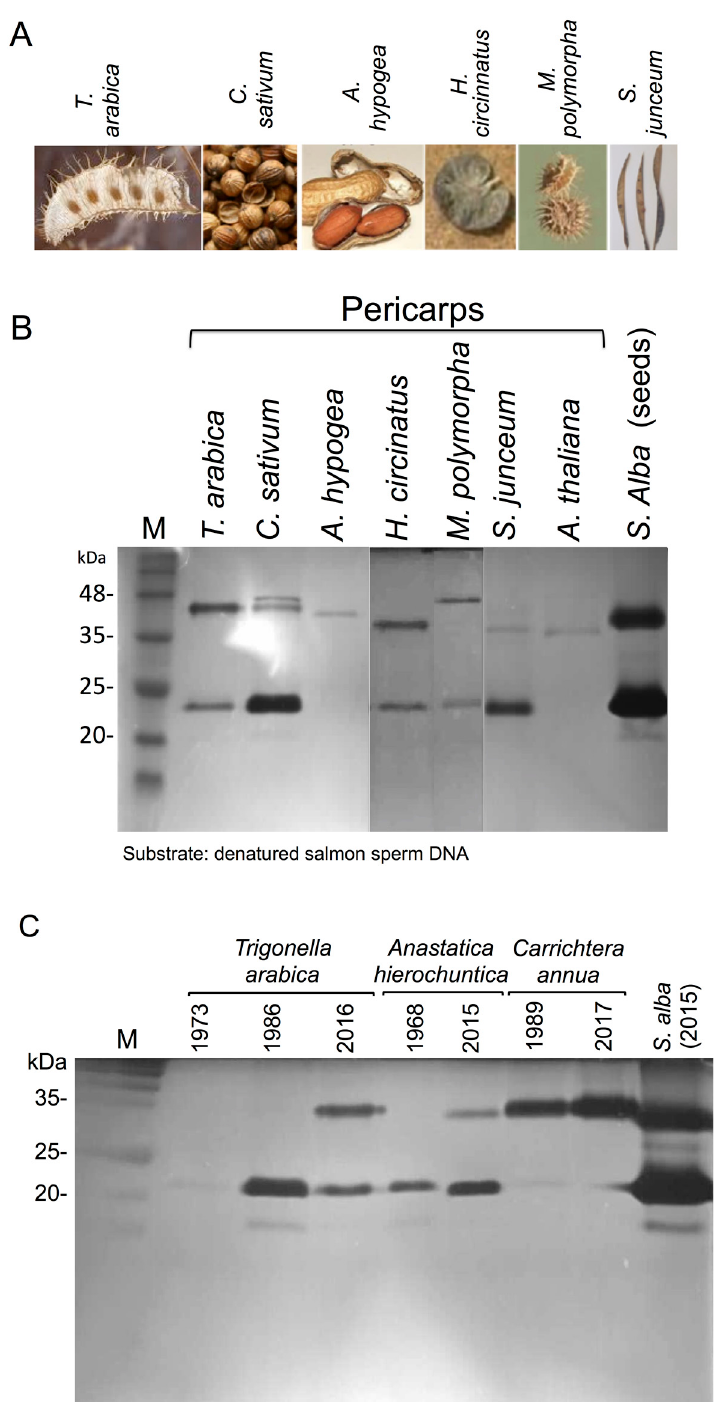
Figure 2. The dead pericarps of various plant species store and release upon hydration active nucleases. ( A ) Dry fruits of Trigonella arabica , Coriandrum sativum , Arachis hypogea , Medicago polymorpha , Hymenocarpus circinnatus and Spartium junceum. ( B ) In-gel nuclease assay. Nuclease activity in pericarps of the above indicated plant species. S. alba seed secretion was used as a control with strong nuclease activity toward denatured salmon sperm DNA. M, protein molecular weight markers. ( C ) Long term persistence of active nucleases within dead pericarps—In-gel nuclease assay. Pericarps from indehiscent fruits of T. arabica , Anastatica hierochuntica and Carrichtera annua collected at the indicated year and stored at room temperature were analyzed for nuclease activity. S. alba pericarps collected from 2015 was used as a control with strong nuclease activity toward denatured salmon sperm DNA. M is the protein molecular weight markers.